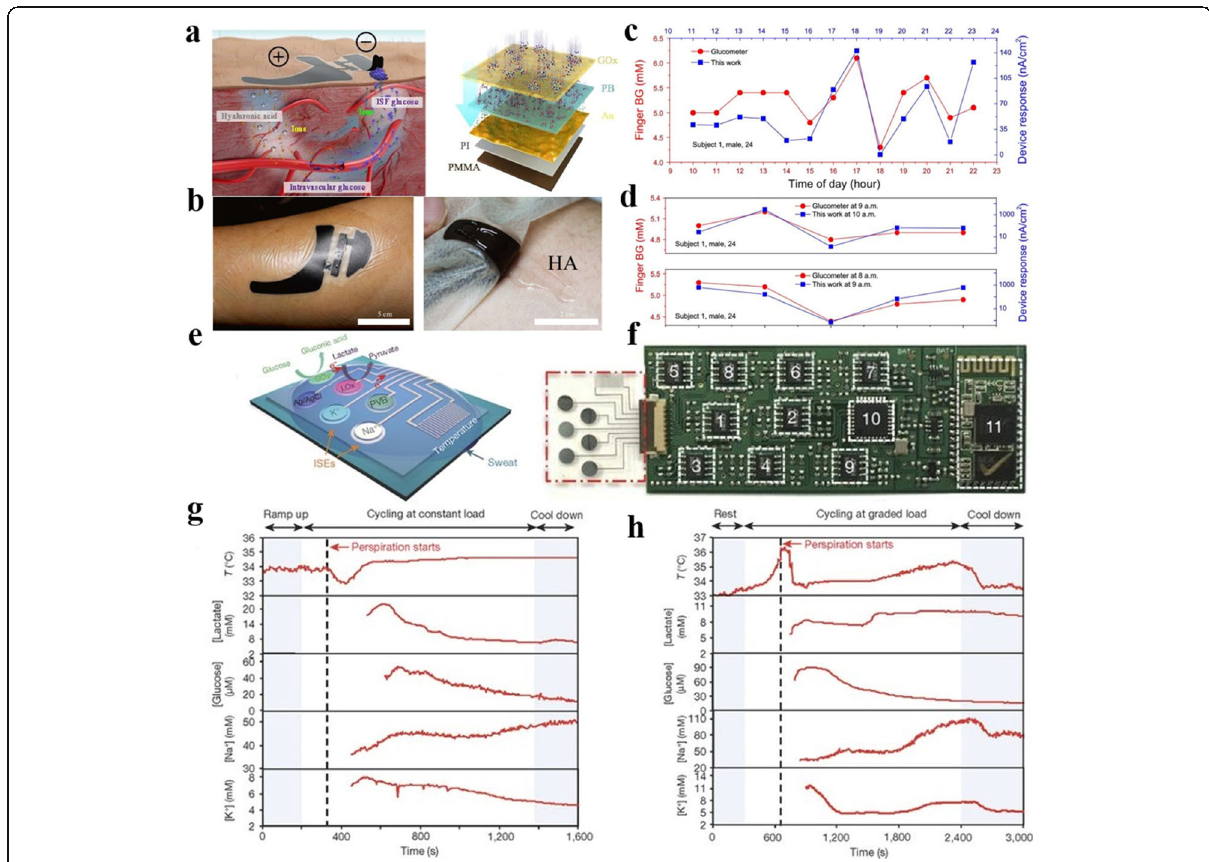
Fig. 9 a Schematic of the ETCs (left) and the biosensor multilayers (right). b A biosensor attached to skin surface for glucose monitoring. c Results of glucose monitoring in one day by a glucometer and a biosensor. d Results of glucose monitoring in 5 days by a glucometer and a biosensor. Adapted with permission from ref. 48. Copyright 2017 American Association for the Advancement of Science. e Schematic of the sensor system for multiplexed sweat analysis. f Photograph of a flexible integrated sensing device. g The result of sweat analysis by wearing the sensor on the forehead of the subject. h The result of sweat analysis by wearing the sensor on the forehead of another subject. Adapted with permission